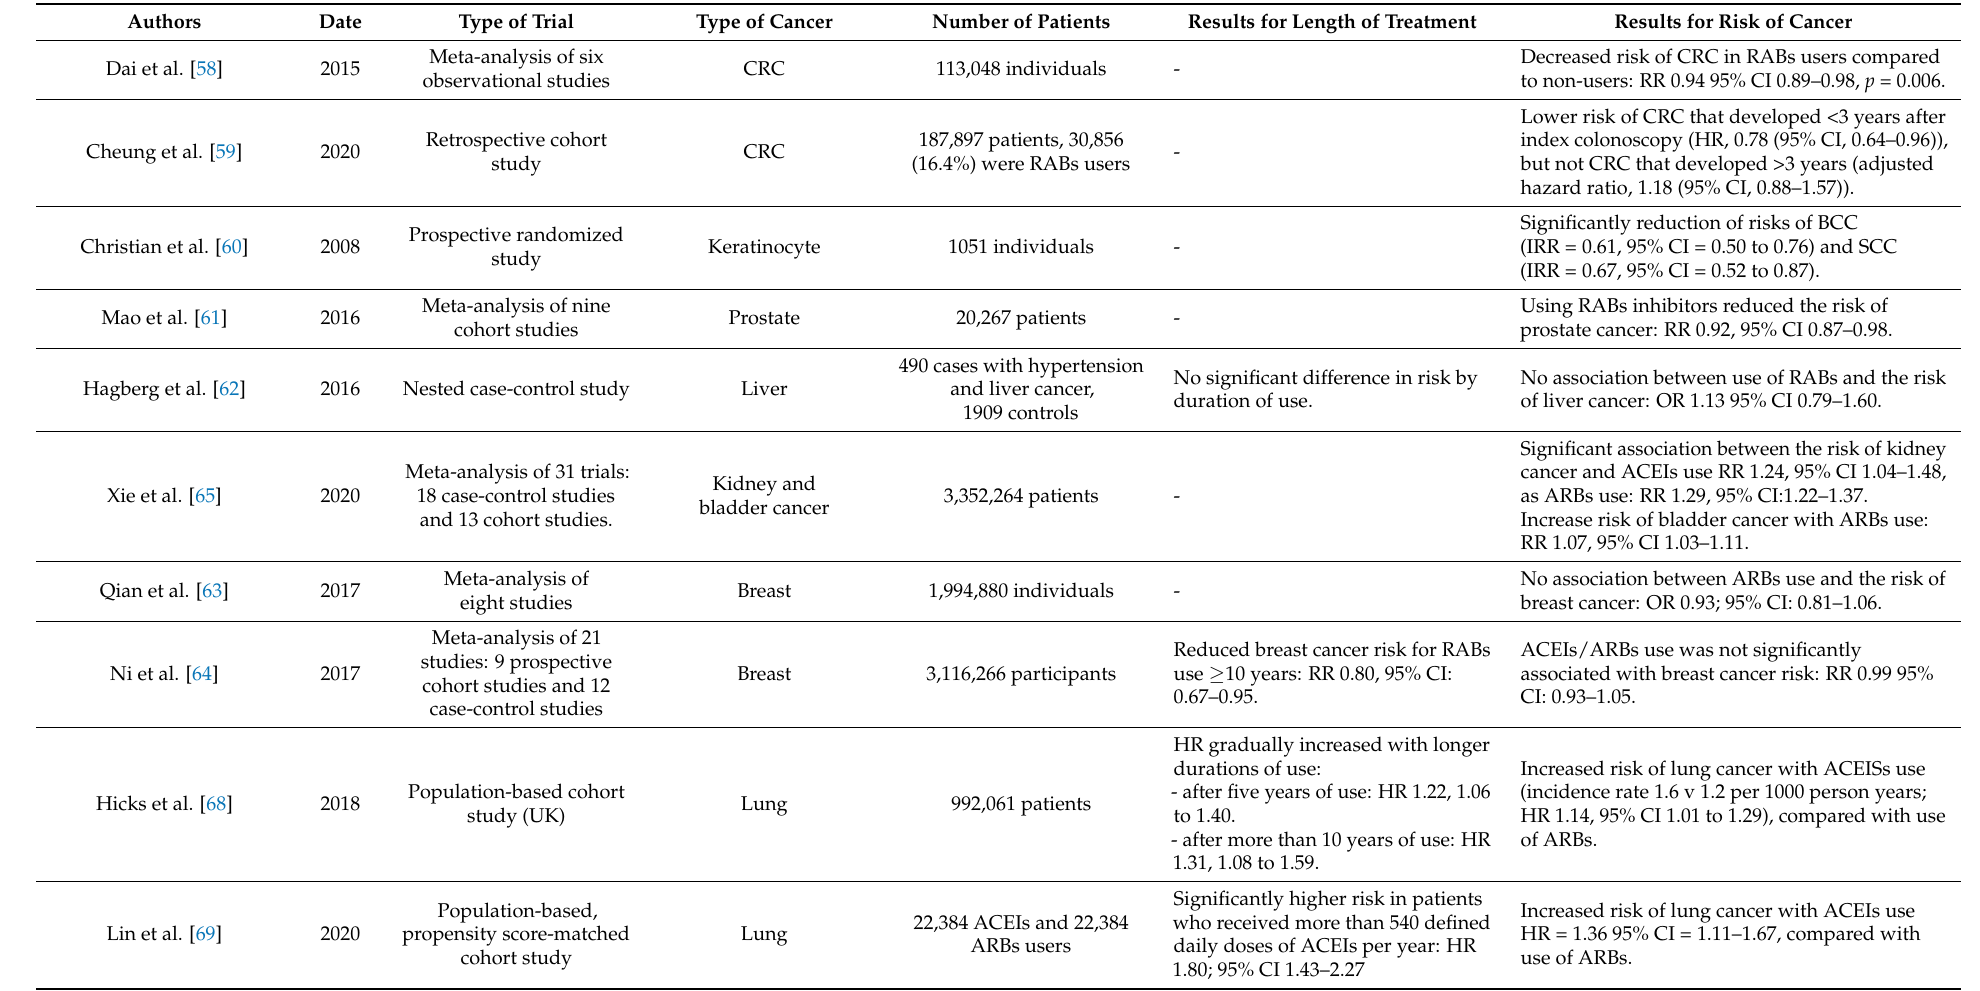
Table 2. Renin–angiotensin receptor blockers and specific organ cancer risks. Abbreviations: ACEIs: angiotensin-converting enzyme inhibitors, ARBs: angiotensin-2 receptor 1